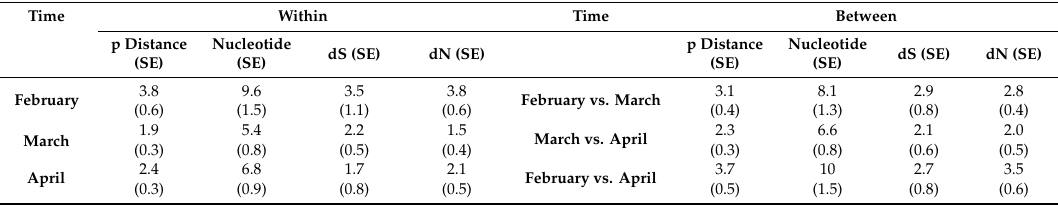
Table 2. Mean genetic divergence within and between Italian strains according to the sampling time (substitutions per 10,000 sites).